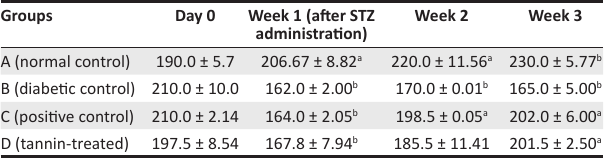
TABLE 1: Effects of tannins on body weight of control and diabetic